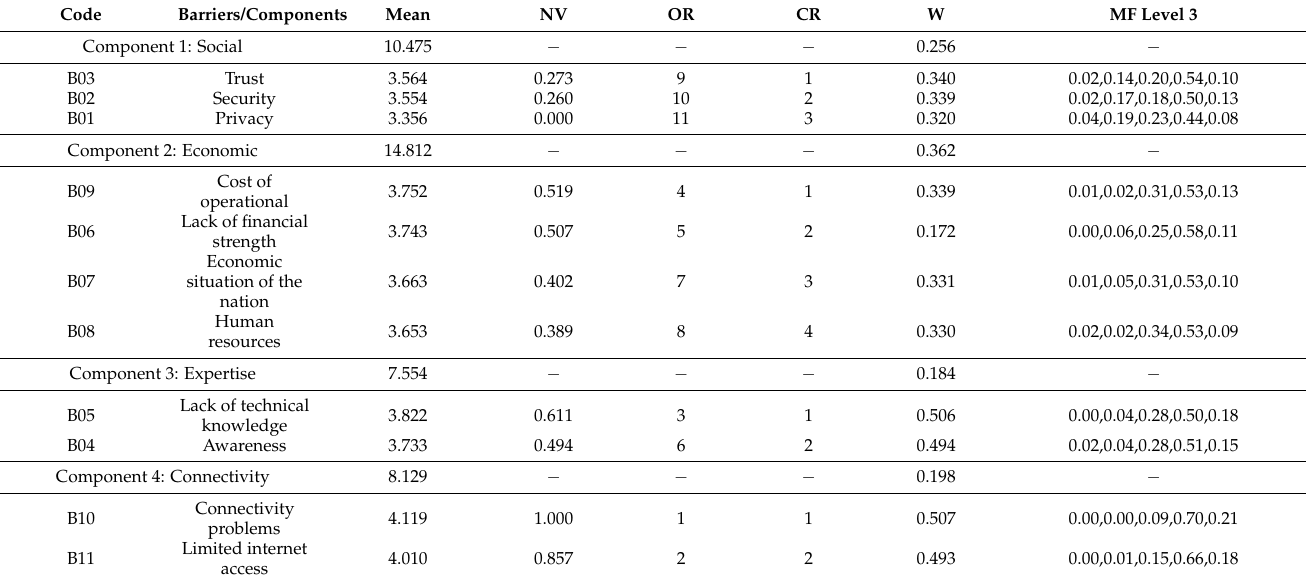
Table 6. Results for FSE of weightings and membership function level